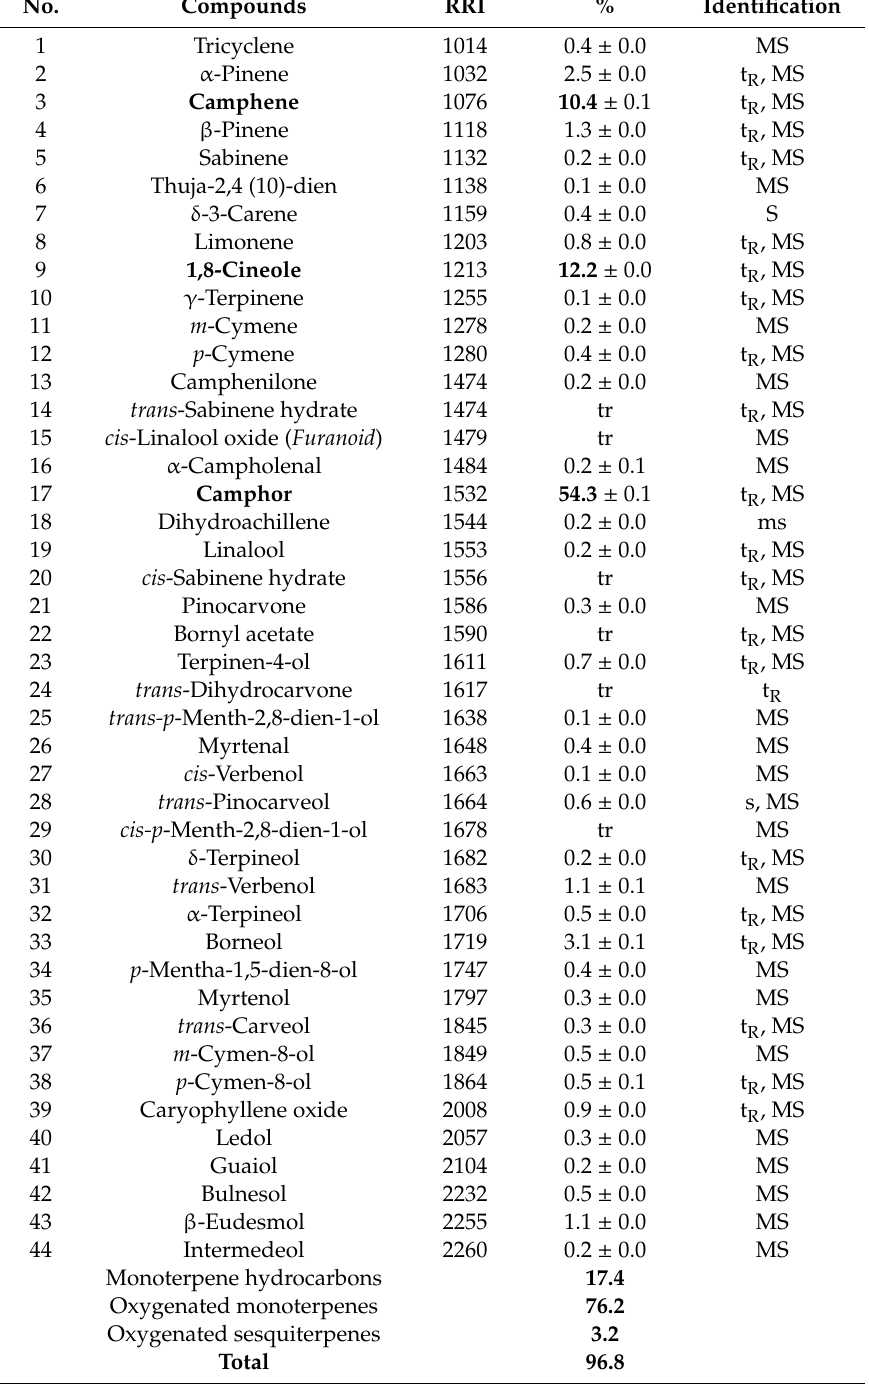
Table 1. Chemical content of the essential oil of Meriandra dianthera